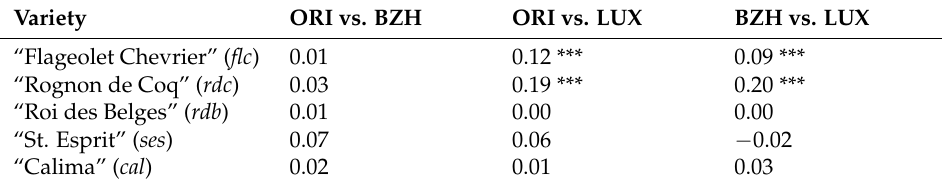
Table 2. Pairwise F ST among populations of five varieties of common bean calculated upon SSR data. ORI stands for “original seed lot”, BZH for “Brittany” and LUX for “Luxembourg”. Variety ORI vs. BZH ORI vs. LUX BZH vs. LUX “Flageolet Chevrier” ( flc ) 0.01 0.12 *** “Rognon de Coq” ( rdc ) 0.03